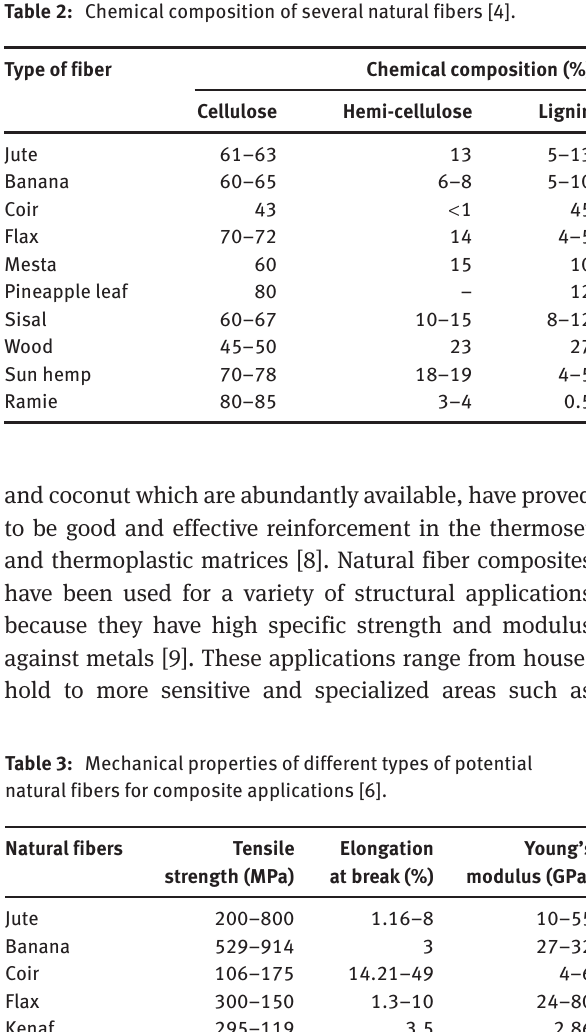
Table 2: Chemical composition of several natural fibers [4].